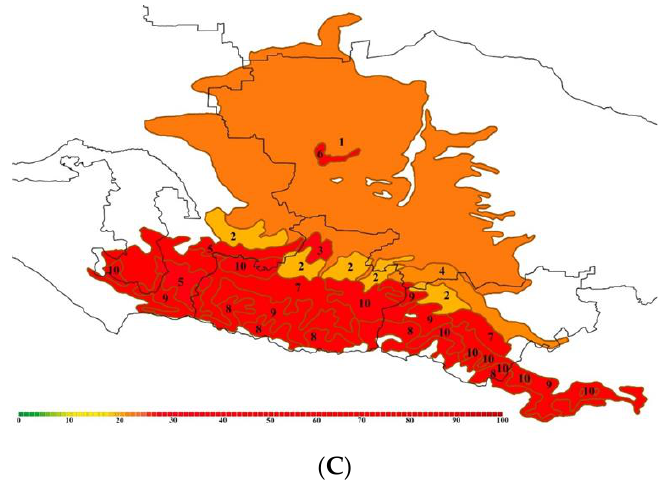
Figure 2. Forecast maps of the degree of deterioration of the biological state (in %) of forest, forest- steppe, steppe, and mountain-meadow soils of the Central Ciscaucasia and the Caucasus regions during their pollution: ( A ) — 100 mg/kg, ( B ) — 1000 mg/kg, ( C ) — 10,000 mg/kg of lead (Pb). Symbols: